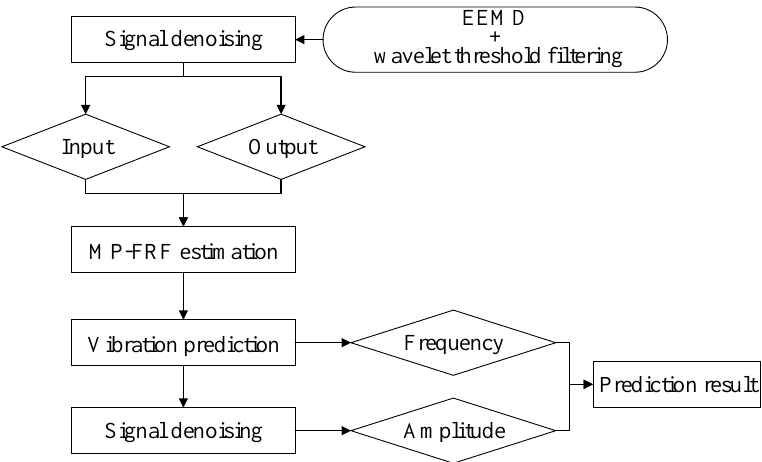
Figure 12. The flow chart for prediction of ground vibration induced by flood discharge.